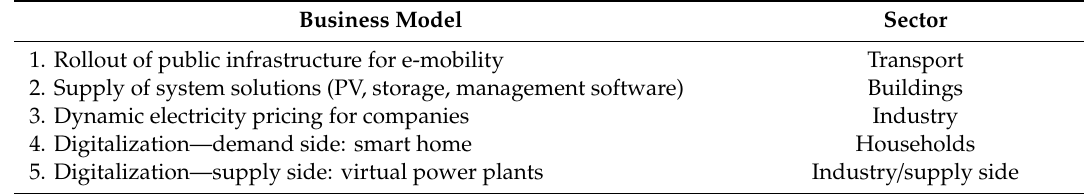
Table 3. Business models and how they a ff ect the core areas of big energy companies.